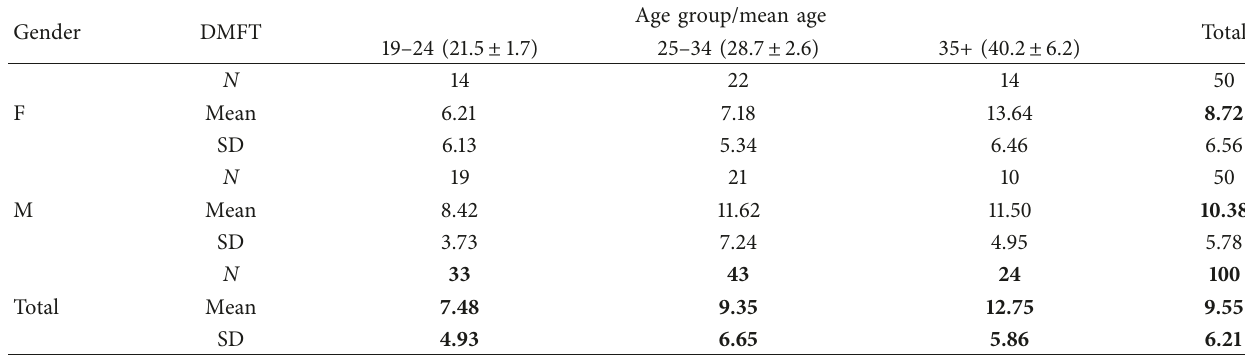
Table 2: DMFT values for adult inmates according to their age group and gender.